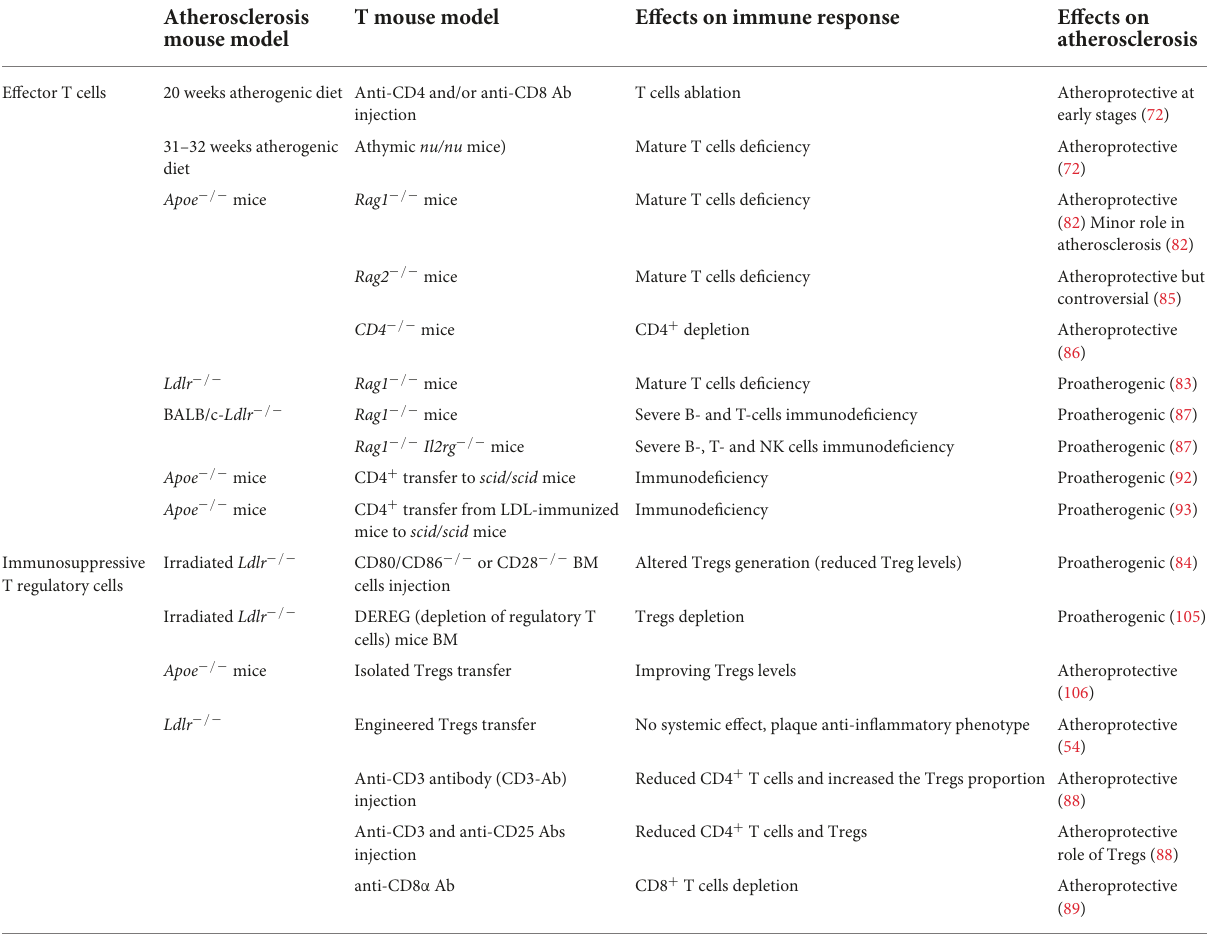
TABLE 3 Effector T cells and immunosuppressive T regulatory cells-related studies in